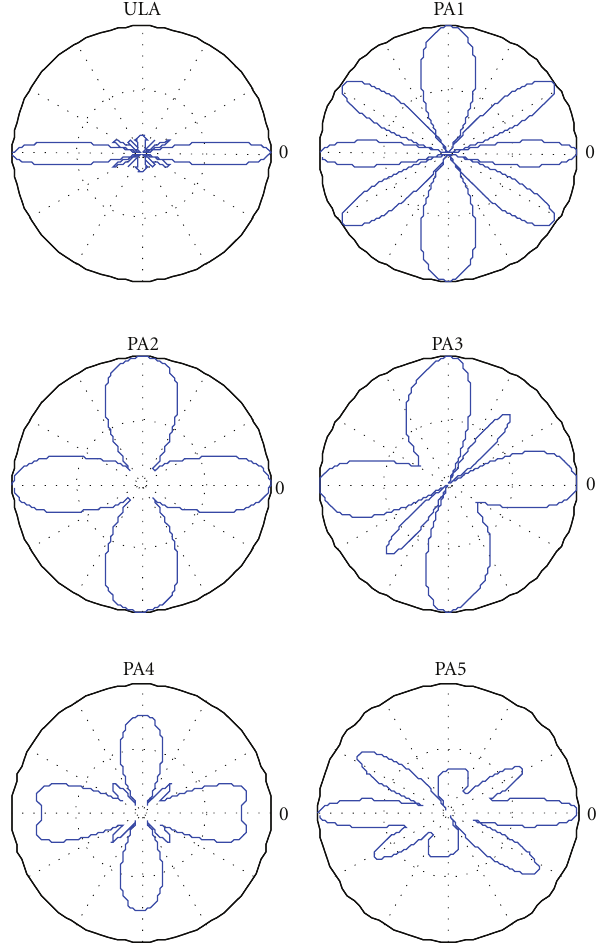
Figure 16: Array factor for ULA and proposed configurations.